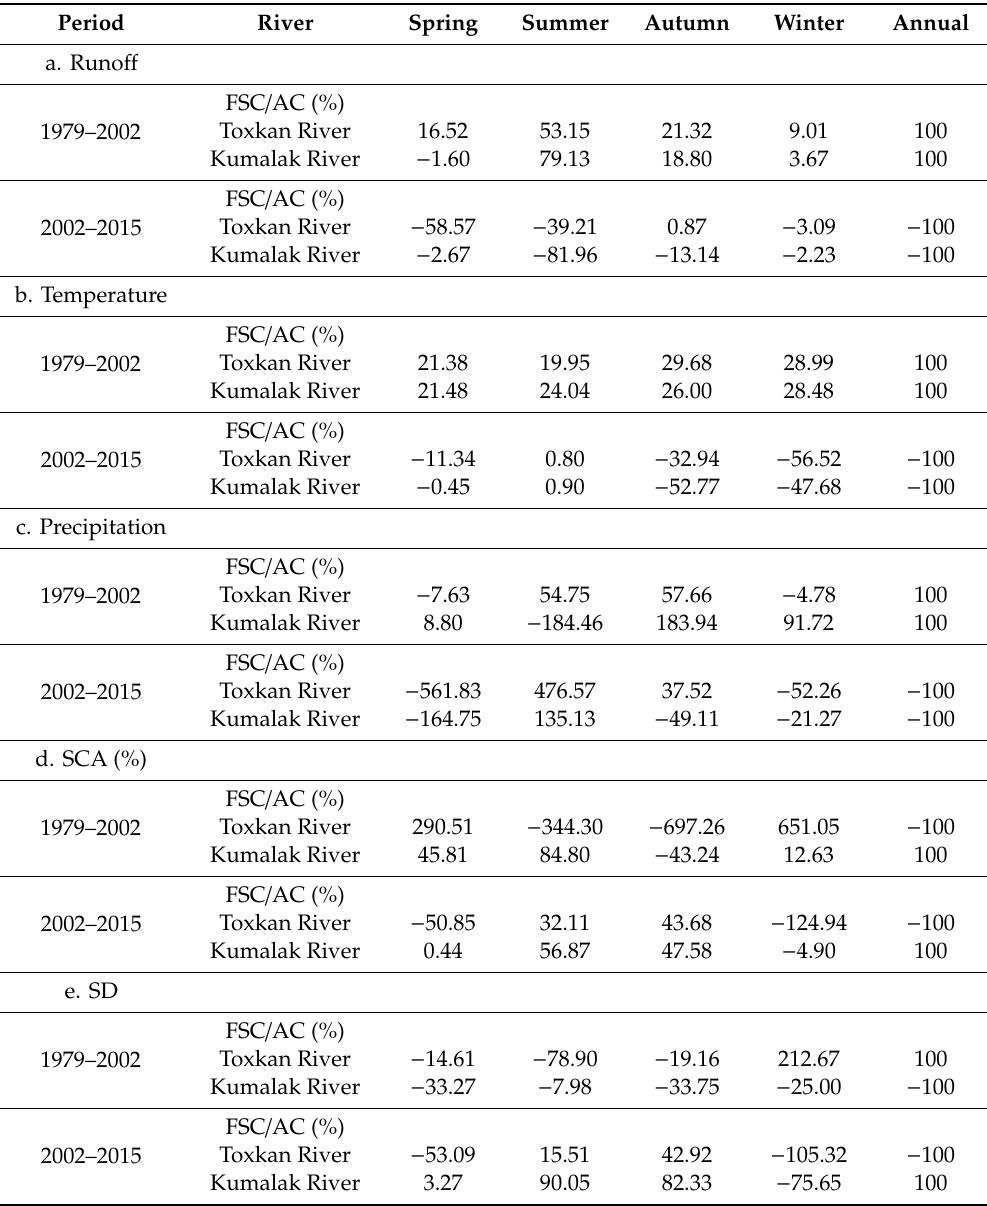
Table 3. The relative contribution of seasonal to annual trend in runo ff , temperature, precipitation, SCA, and SD in 1979–2002 and 2002–2015. Period River